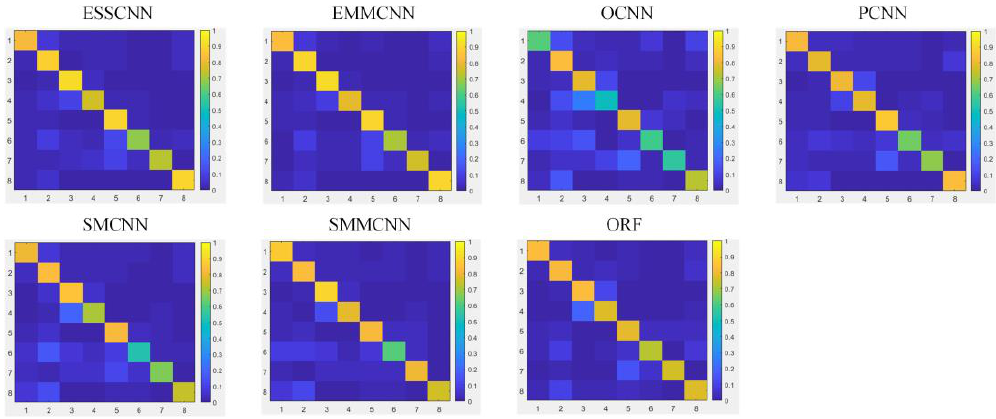
Figure 10. Confusion matrices of testing samples in the Cixi dataset for the ESSCNN, EMMCNN, OCNN, PCNN, SMCNN, SMMCNN, and ORF methods. The numbers 1 to 8 in horizontal and vertical axis denote the water, farmland, woodland, grassland, building, road, impervious surface, and facility land classes, respectively. ESSCNN: extended topology-preserving segmentation (ETPS)-based single-scale and single-feature convolutional neural network (CNN); EMMCNN: ETPS-based multi- scale and multi-feature CNN; OCNN: object-based CNN; PCNN: patch-based CNN; SMCNN: simple linear iterative clustering (SLIC)-based multi-scale CNN; SMMCNN: SLIC-based multi-scale and multi-feature CNN; ORF: object-based random forest.